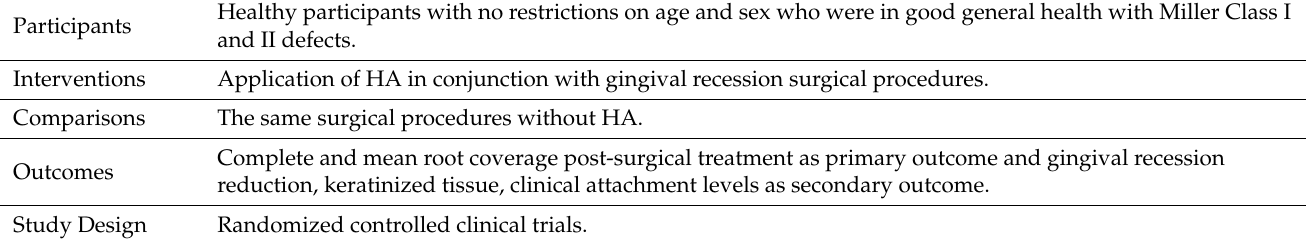
Table 1. Selection